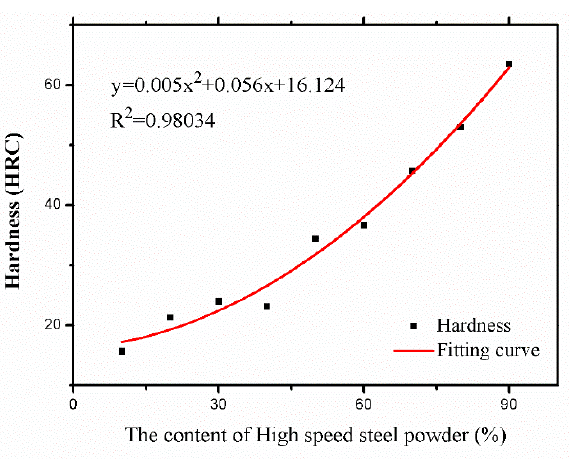
Figure 2. Polynomial fitting curve.